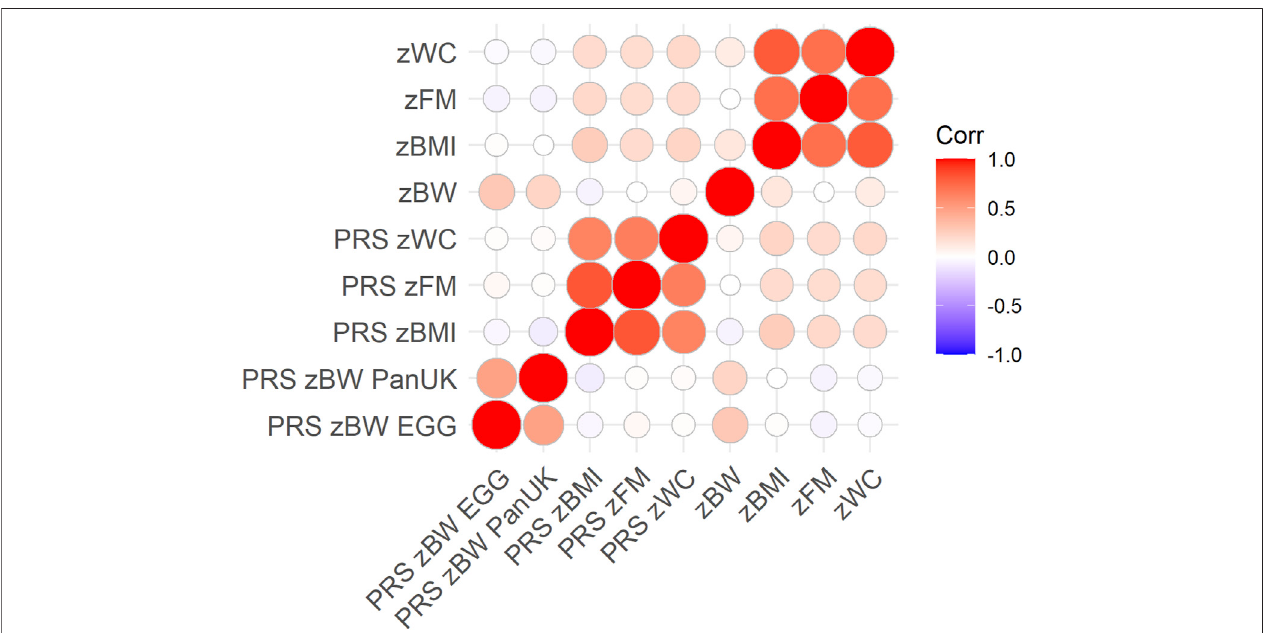
FIGURE1| Pearson ’ scorrelation coef fi cientsacrossPRSsand phenotypic traits,considering onlycomplete pairwiseobservations (N=1,066).Thecolorintensity and size of the circles indicate the degree of correlation.